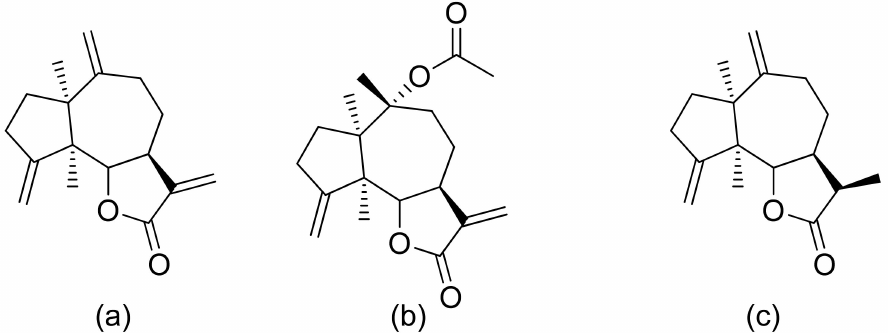
Figure 3. Sesquiterpene lactones from Portuguese liverwort ( a – c ). Kozioł et al. synthesized a 4- tert -butylcyclohexanone bromolactone derivative (Figure 4a), which was proven to inhibit the growth of E. coli , S. aureus , and B. subtilis . Additionally, at a concentration of 200 µ g/mL, up to 60% of bacterial growth was inhibited [19]. Another previous study analyzed the antibacterial activity of bromolactone with a preserved carane system (Figure 4b). This bromolactone proved to have satisfactory growth inhibitory activity with an MIC90 value of 200 µ g/mL [20].